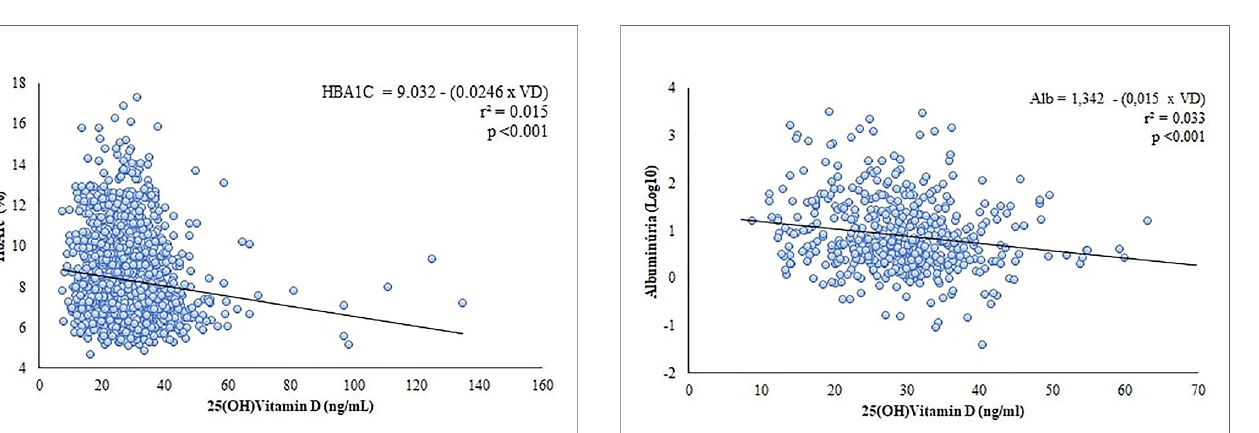
FIGURE 5 | Linear regression between vitamin D levels